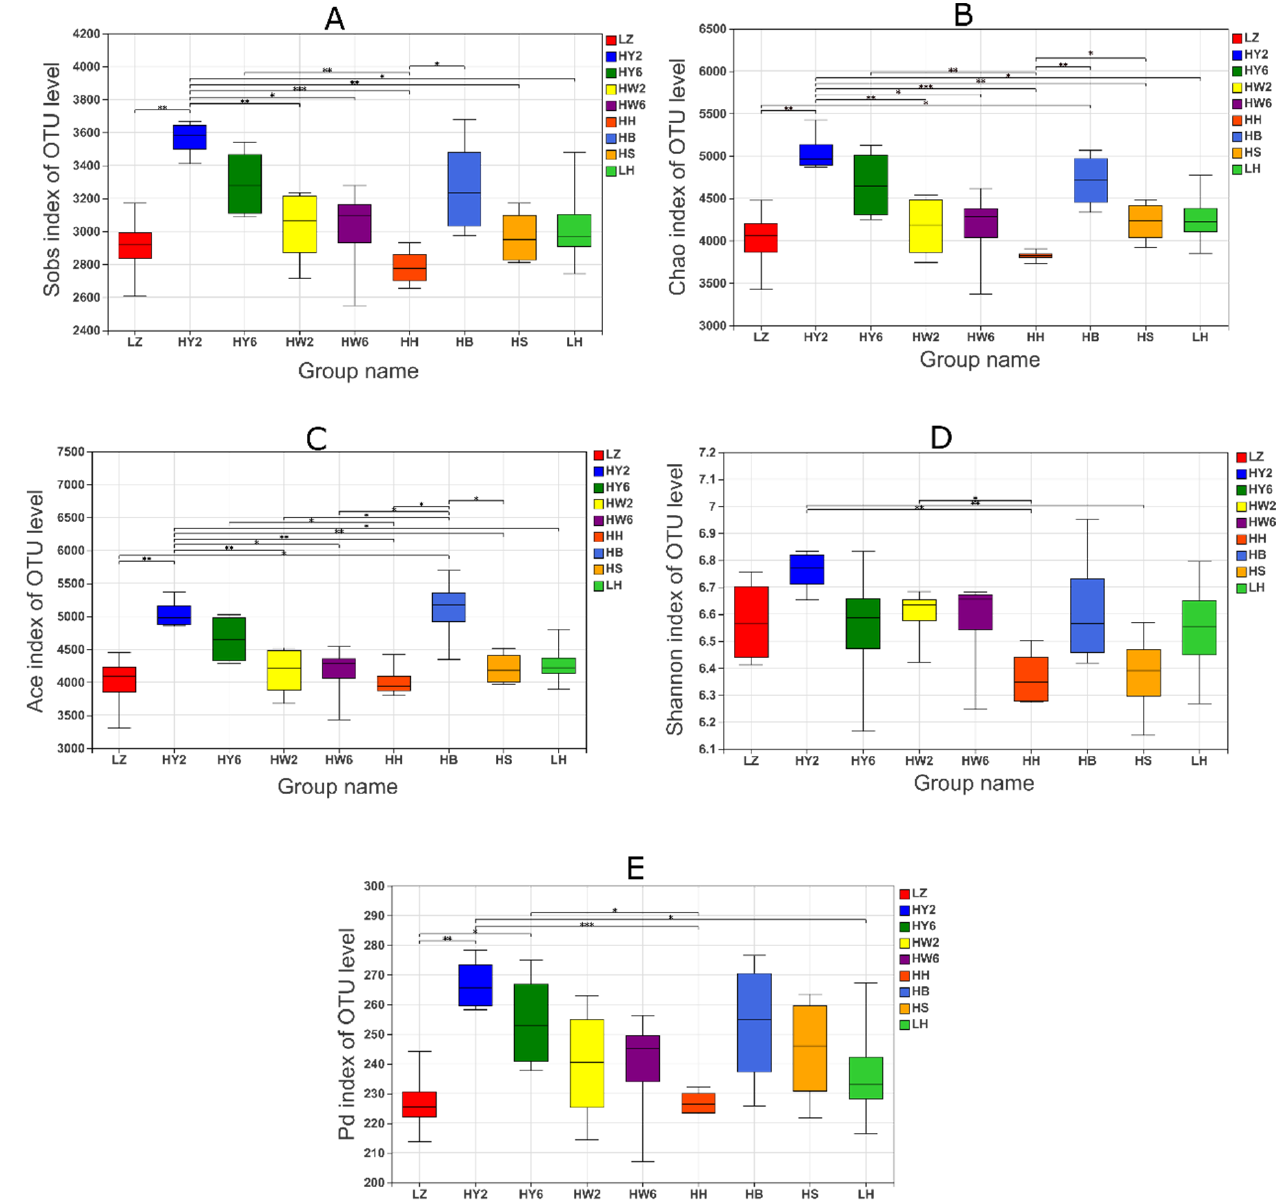
Figure 5. Alpha diversity of the bacterial community. ( A ) The number of observed species (Sobs), ( B ) Chao indices, ( C ) Ace indices, ( D ) Shannon indices, and ( E ) phylogenetic diversity indices (Pd). LZ, HY2, HY6, HW2, HW6, HH, HB, HS, and LH; continuous cropping of C. chinensis for 5 years , maize continuous cropping for 2 years, maize continuous cropping for 6 years, P. multiflorum continuous cropping for 2 years, P. multiflorum continuous cropping for 6 years, sweet potato continuous cropping for 2 years, F. thunbergia continuous cropping for 2 years, cabbage continuous cropping for 2 years, and fallow field, respectively. Asterisks (*, **, and ***) show significant differences at p ‐ value < 0.05, 0.01, and 0.001, respectively.